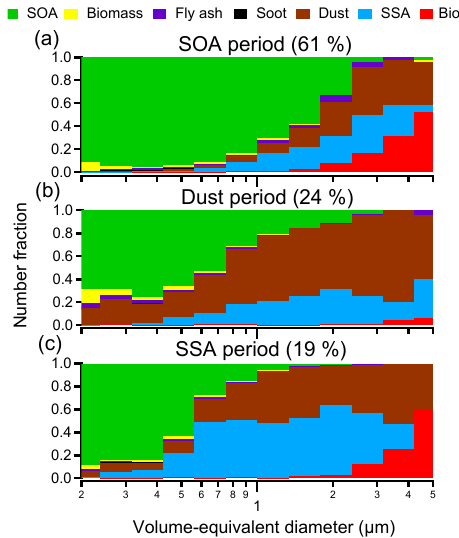
Figure 5. Size distributions for specific particle-rich time periods: (a) SOA-rich periods (14–17 June and 7–11 July 2013), (b) dust- rich periods (12–13 June and 26–28 June 2013), and (c) SSA-rich periods (10–11 June and 3–6 July 2013). SOA periods were dom- inant throughout the times when samples were analyzed during SOAS (61%), high-dust periods (24%) (Allen et al., 2015), and SSA periods (19%) of the time. SSA periods were defined in Bondy et al. (2017). ∗ Literature-identified SSA periods and dust periods overlap from 11 to 13 June 2013; thus the percentage of SOA, dust, and SSA periods is greater than 100% due to double counting of that time period. Only particles with volume-equivalent diameters between 0.2 and 5µm are shown due to too few particles present at larger sizes for statistical